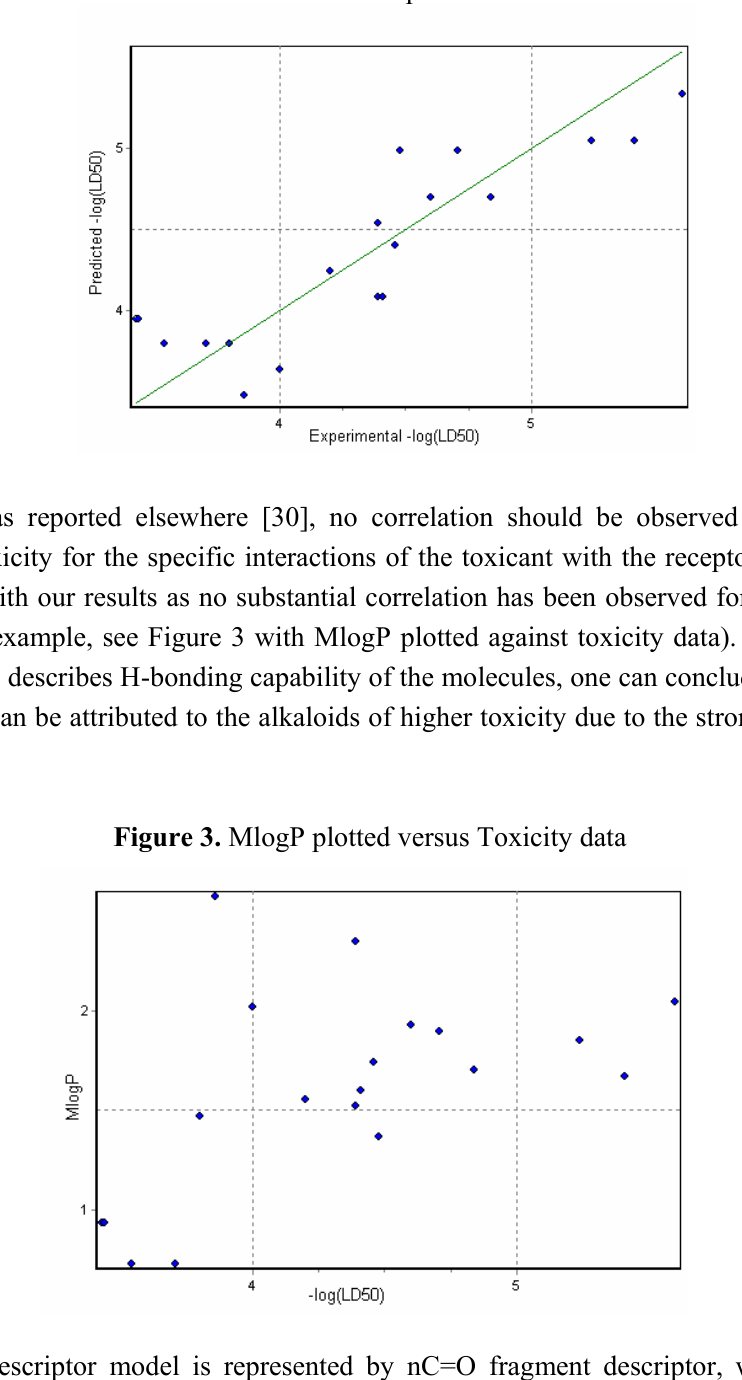
Figure 2. Correlation of Predicted versus Experimental toxicities for model A (Eqn.4)